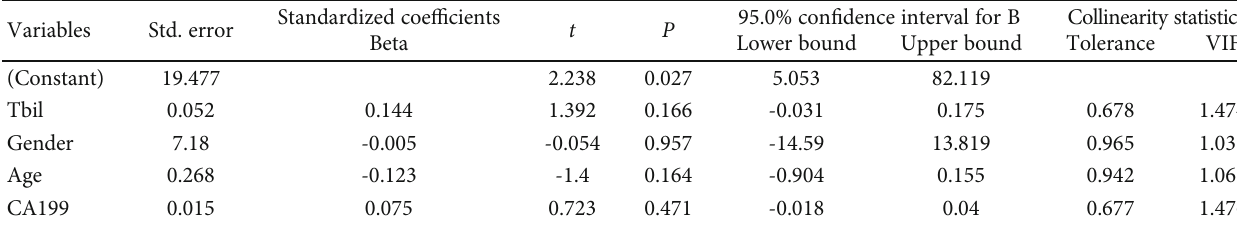
Table 6: Multiple linear regression for